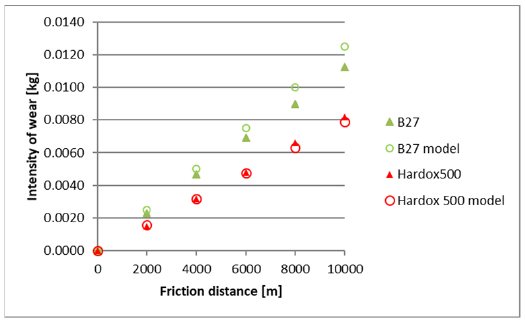
Figure 13. The course of theoretical and empirical wear of B27 and Hardox 500 steels in heavy soil.